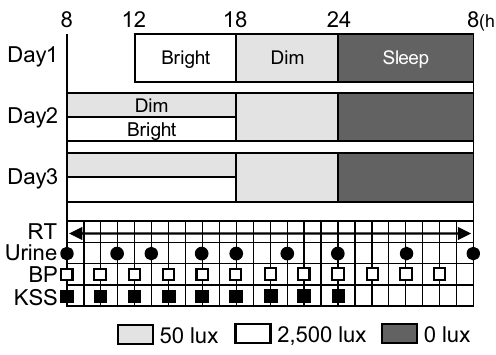
Figure 1. Overview of the experimental protocol. Numbers above the graphic indicate hours in the day that served as measurement period boundaries. RT was monitored continuously (arrow). Black circles indicate approximate urine sample collection times. White squares indicate BP measurement time points. Black squares indicate KSS